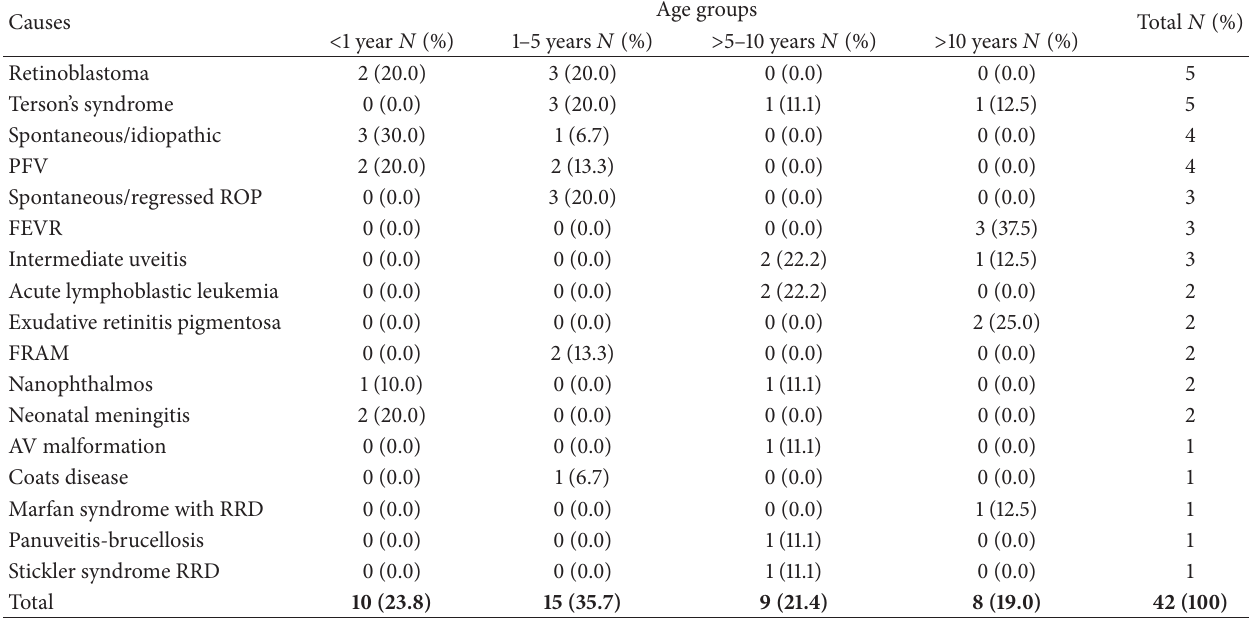
Table 3: Causes of vitreous hemorrhage for nontraumatic eyes according to the age group.